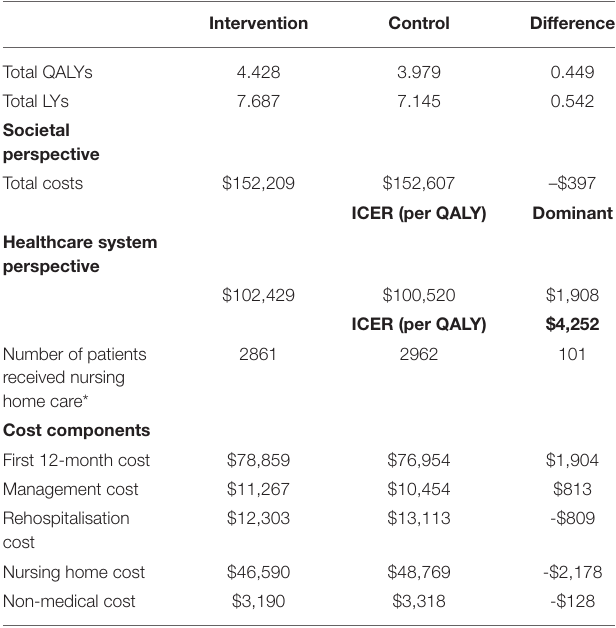
TABLE 2 | The results of base cost-effectiveness